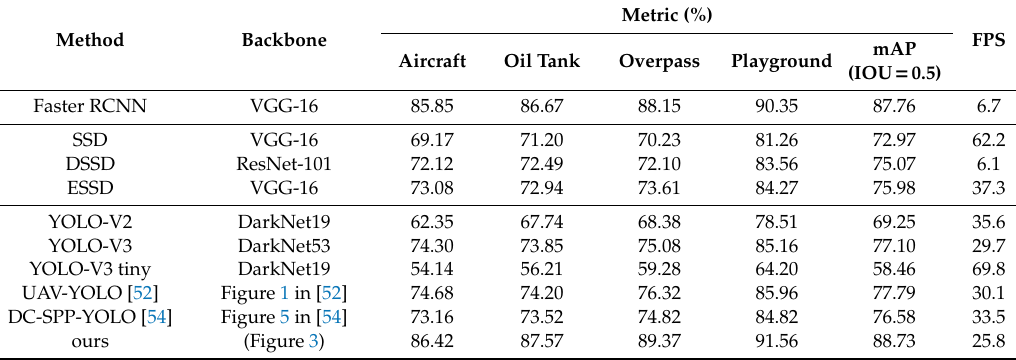
Table 7. Experimental comparison of accuracy and speed in the RSOD dataset.